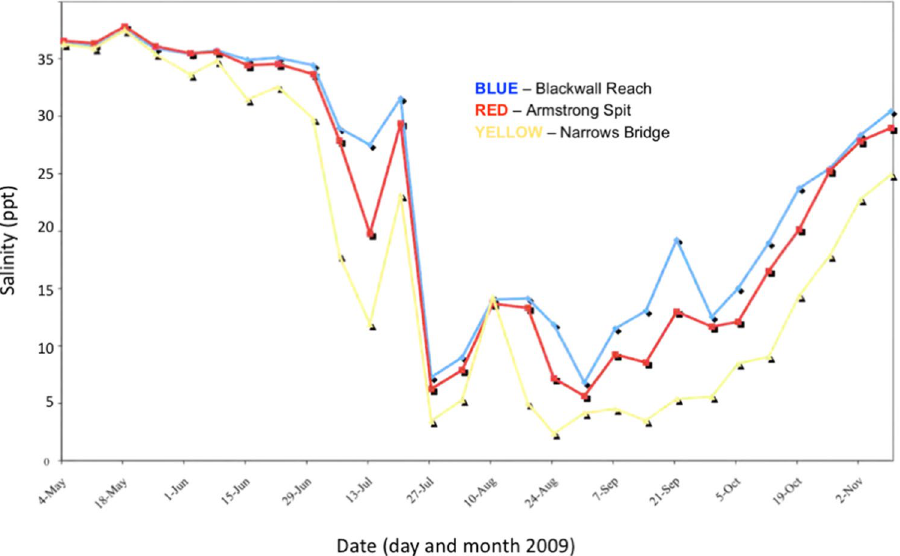
Figure 9. Surface (0.5 M depth) salinity of the Swan-Canning Riverpark at three locations from 4th May 2009 through 2nd Nov. 2009. Salinity fell rapidly in July to 5 ppt or less and remained below 15 ppt through early or mid October. Prepared by the Department of Water and Environmental Regulation for the Department of Biodiversity, Conservation and Attractions, Western Australia.